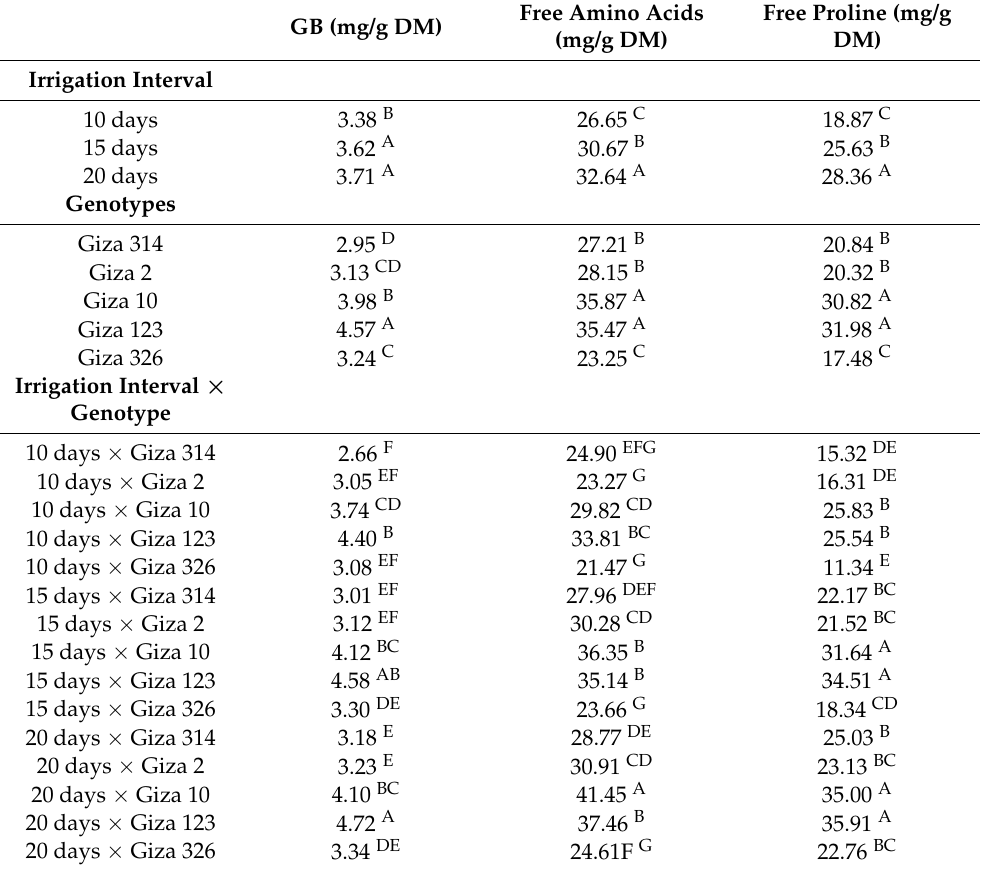
Table 5. Osmoregulators of five maize genotypes as affected by normal (10 days), mild (15 days), and severe (20 days) water stress at the vegetative stage. Means within the same column distinguished by different letters differ significantly according to the Tukey’s posthoc HSD test at p = 0.05. GB (mg/g